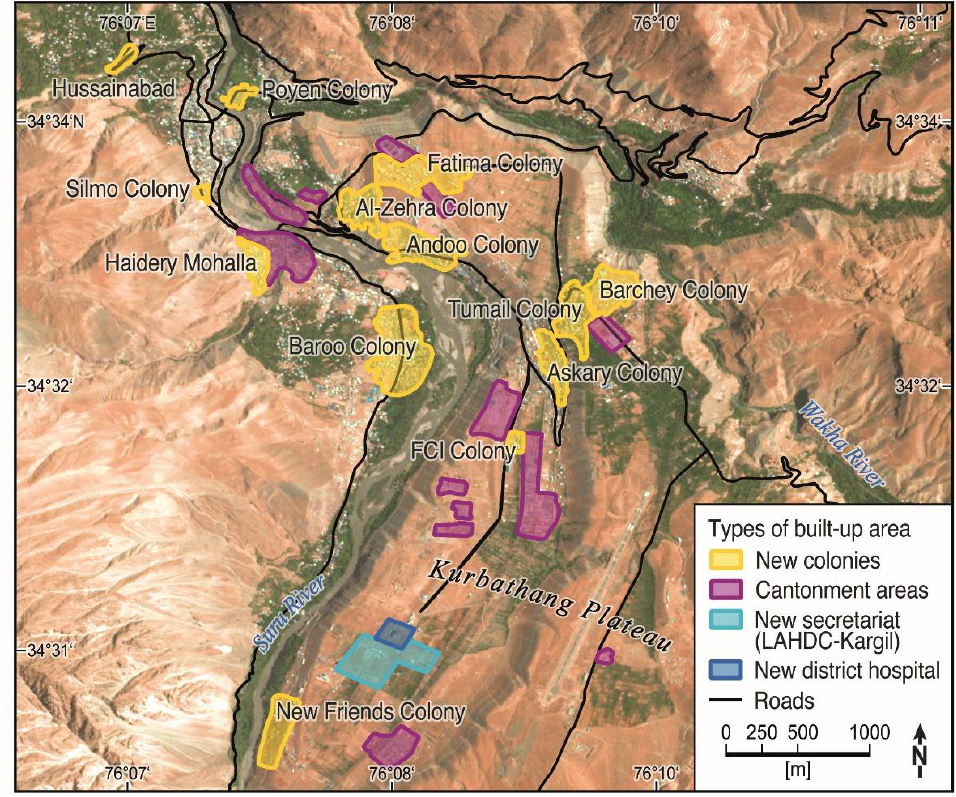
Figure 3. Establishment of new residential colonies and army areas (Source: PlanetScope (8 June 2020); draft and cartography: Altaf Hussain).